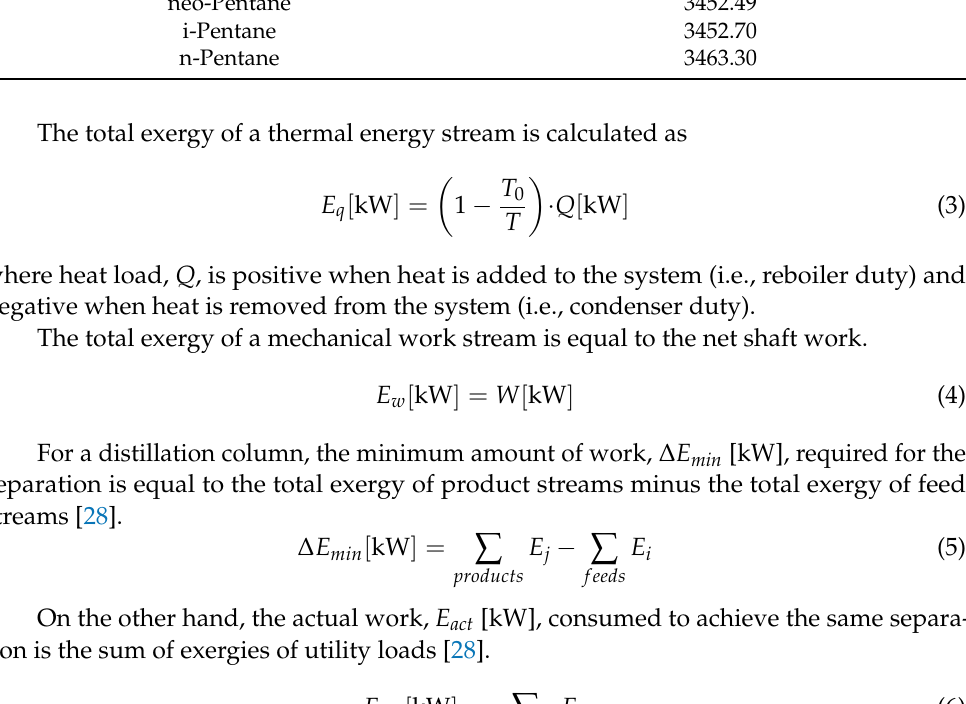
Table 2. Standard chemical exergies of gas-phase components at 298.15 K and 101,325 Pa [47,48]. Component e ch ( kJ Propane 2154.00 i-Butane 2803.41 n-Butane 2805.80 i-Butene 2646.28 neo-Pentane 3452.49